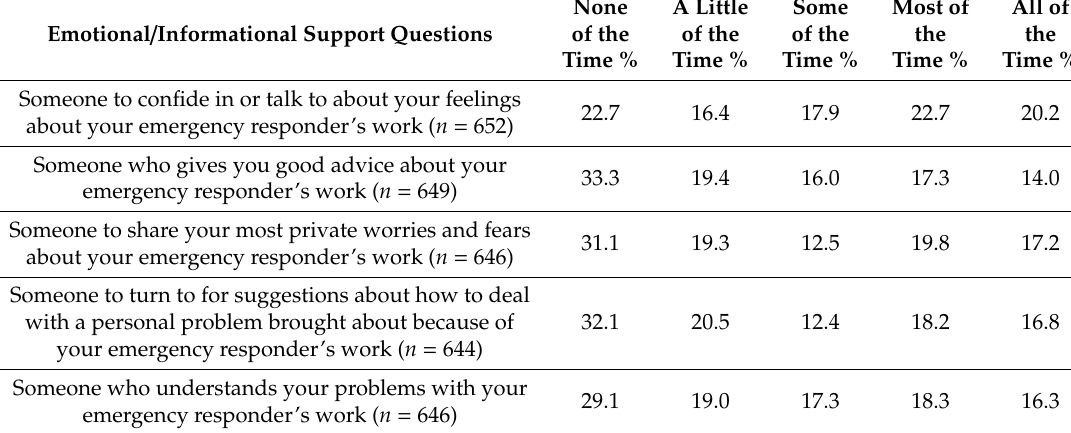
Table 2. Results for emotional / informational support measure.